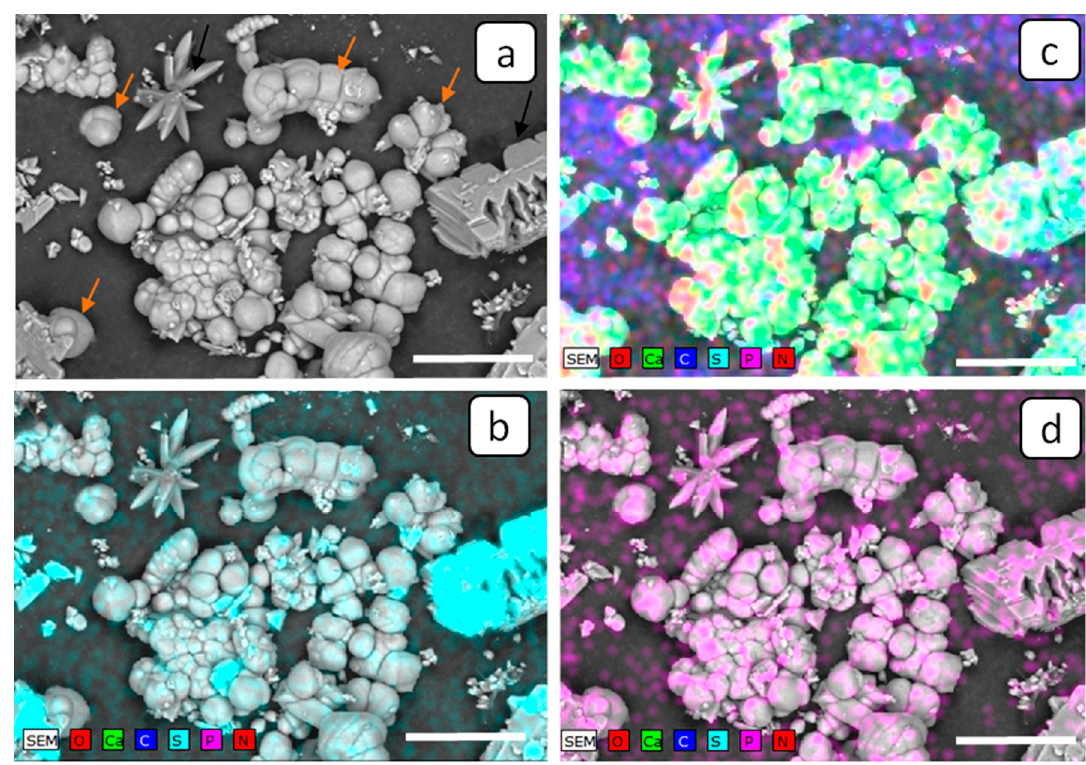
Figure 6. SEM image ( a ) and SEM-EDS map of element distribution for calcium sulfate isolated in presence of ADMP-F: distribution of sulfur ( b ), of all elements ( c ) and of phosphorus ( d ); gypsum particles are indicated by black arrows and Ca-ADMP-F phases by red arrows; scale bar 300 µm.